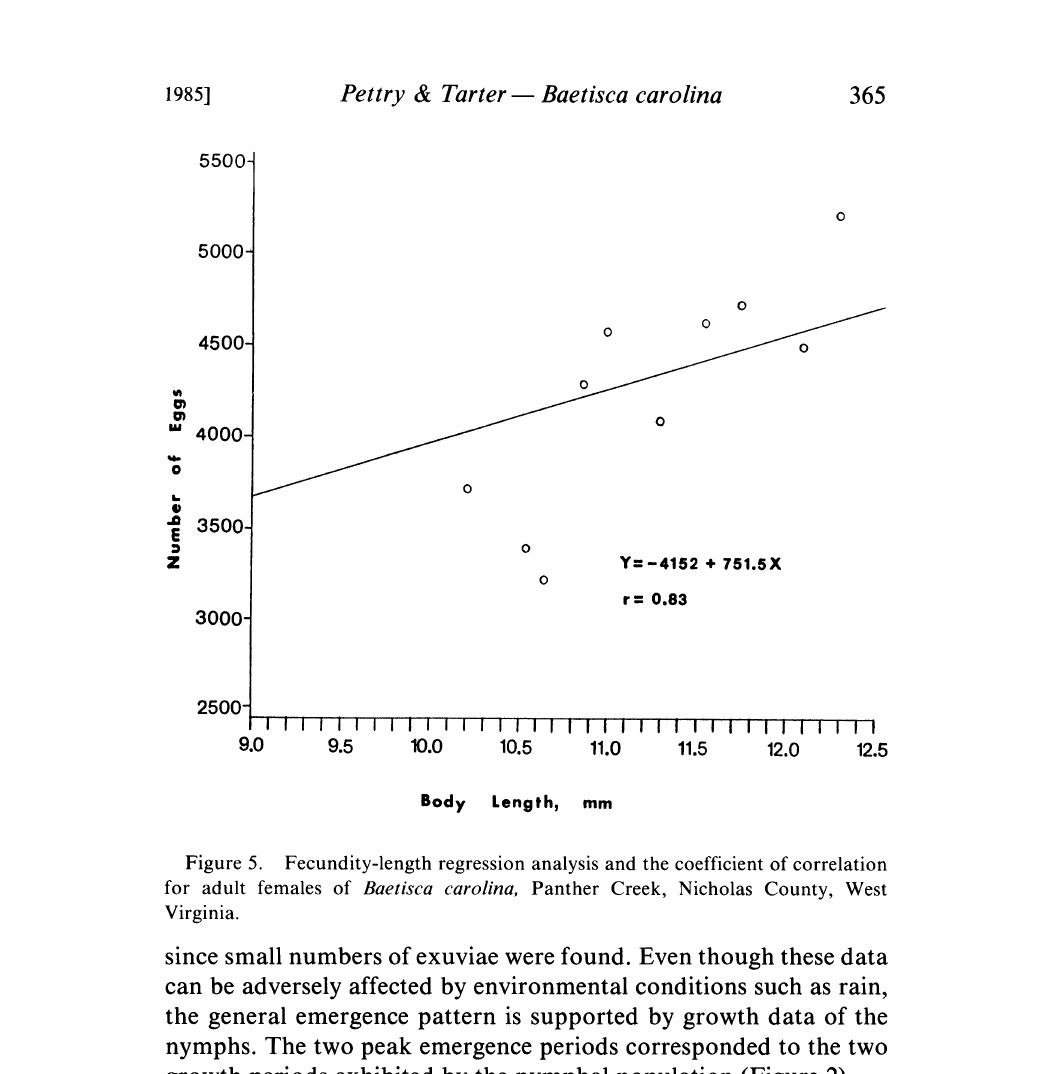
Figure 5. Fecundity-length regression analysis and the coefficient of correlation for adult females of Baetisca carolina, Panther Creek, Nicholas County, West